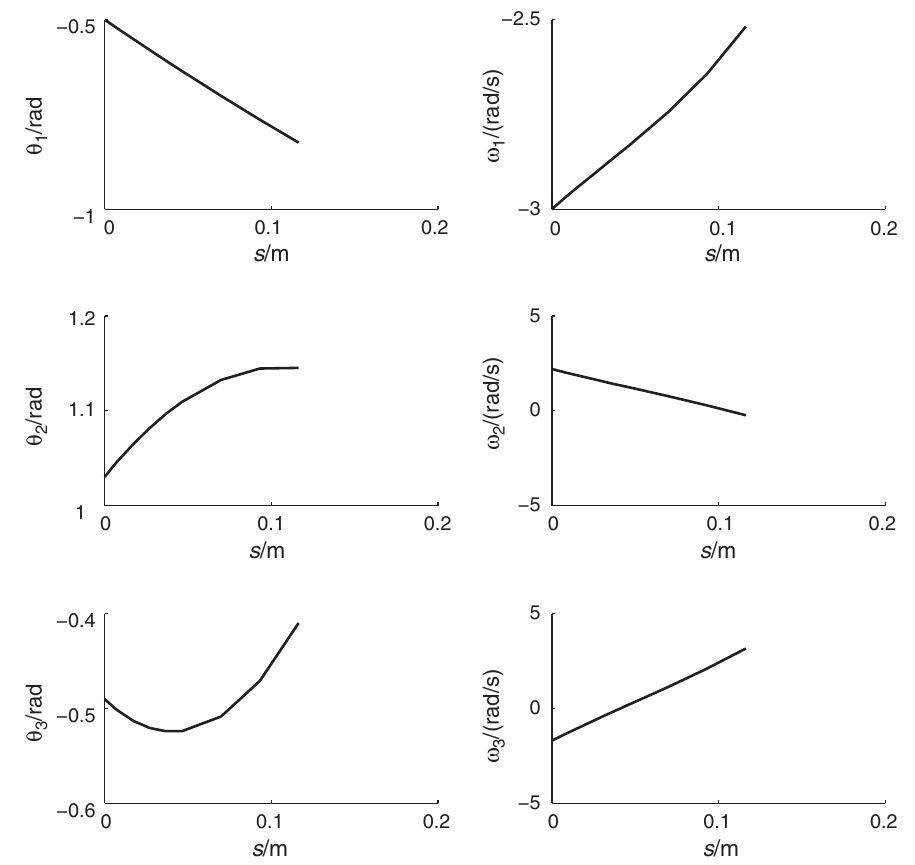
Fig. 9. Geodesic gait of swing leg from state 0 to state 1.